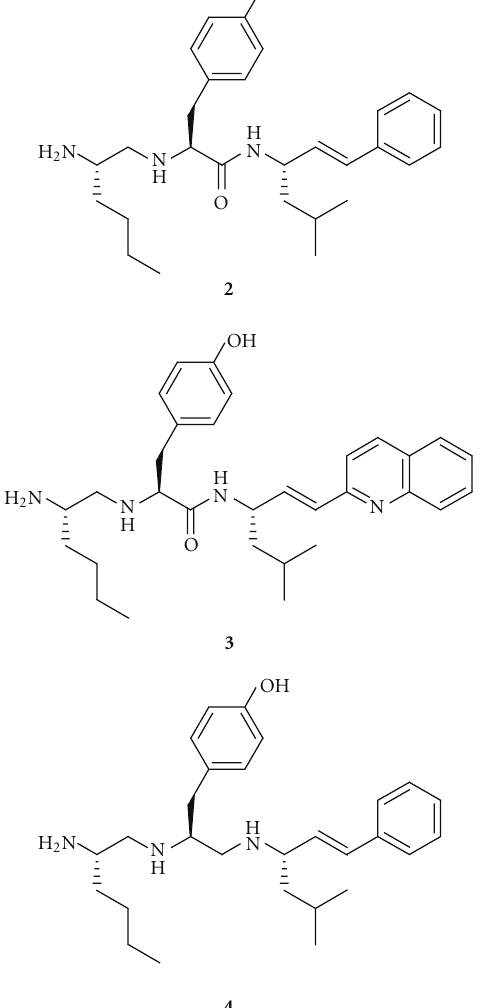
Figure 7: Higha ffi nity Ang IV receptor binding analogues that incorporate one or two reduced peptide bonds ( Ψ [CH 2 NH]) and a styrene moiety replacing the C-terminal tripeptide His-Pro-Phe of Ang IV.